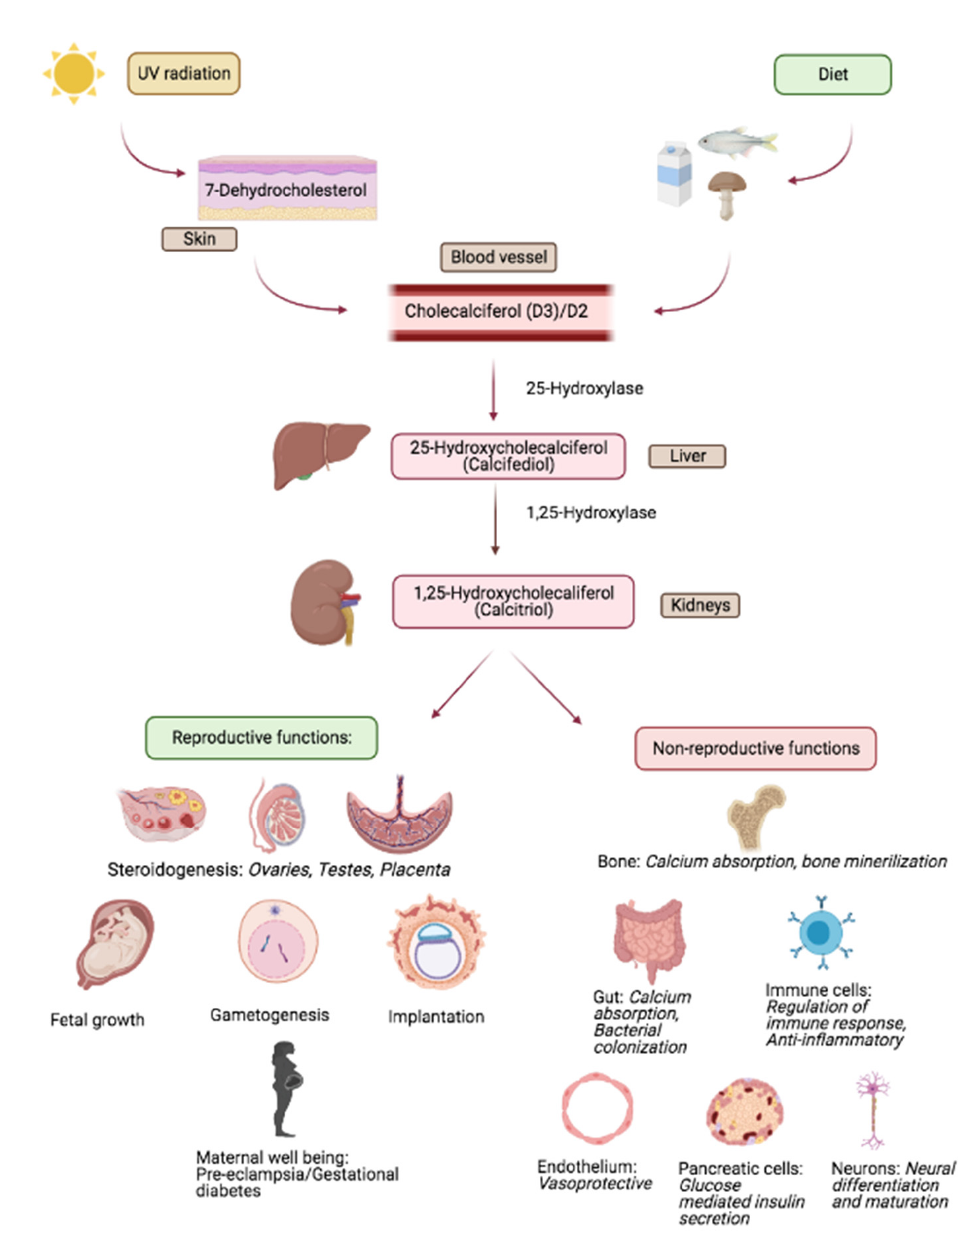
Figure 1. Overview of vitamin D metabolism and salient reproductive and non-reproductive actions. Adapted from study by Luk et al. [52].